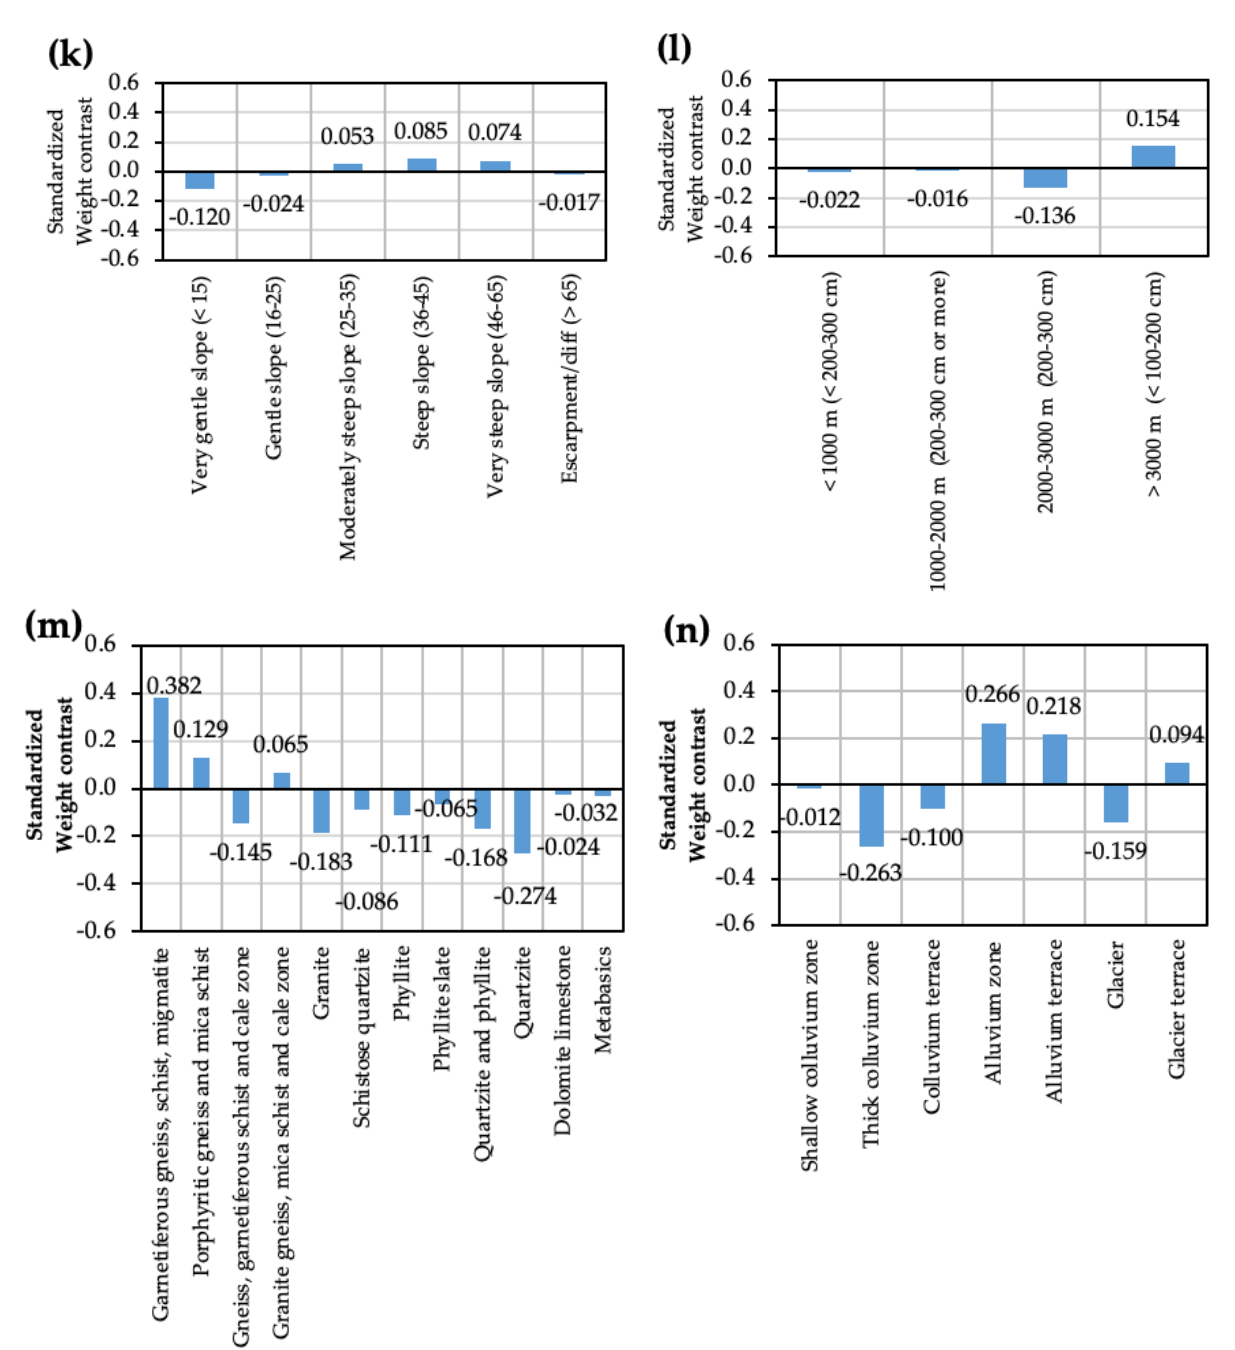
Figure 7. The graphs of landslide causative factors and their corresponding standardized weight contract value: ( a ) land use/cover; ( b ) slope aspect; ( c ) distance to streams; ( d ) distance to roads; ( e ) distance to thrust; and ( f ) distance to lineaments; ( g ) distance to faults; ( h ) soil type; ( i ) slope depth; ( j ) relative relief; ( k ) slope angle; and ( l ) altitude zone based on rainfall; ( m ) lithology; and ( n ) geomorphology.